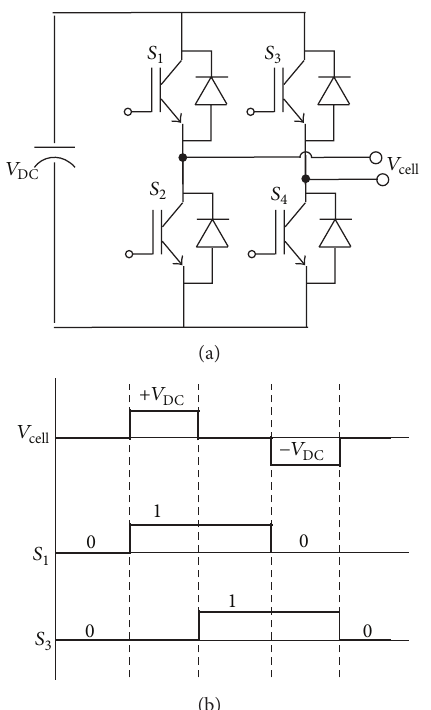
Figure 3: (a) The H-bridge cell unit, consisting of four active devi- ces. (b) The four possible switching states. 𝑆 2 is complementary to 𝑆 𝑆 1 , and 4 is complementary to